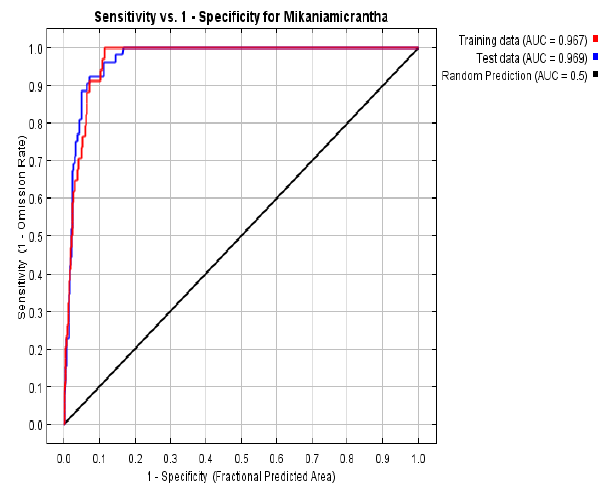
Figure 7. Sensitivity vs. 1-Specificity curve